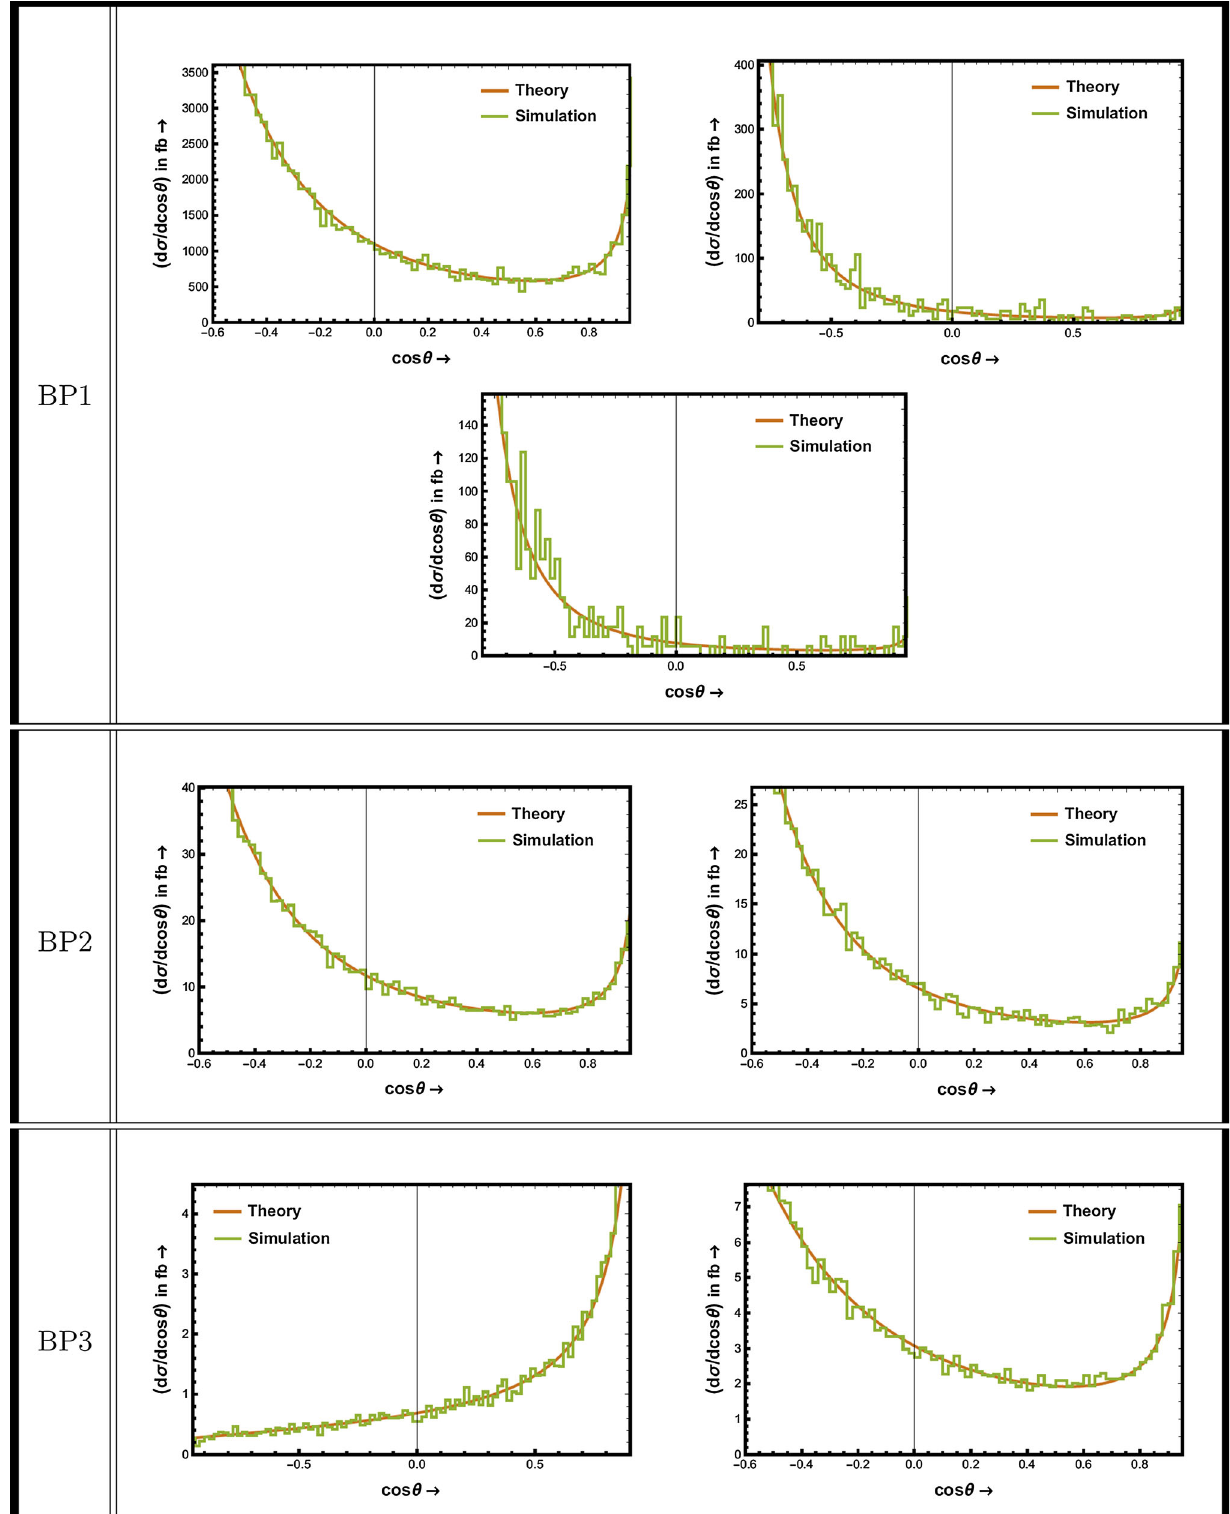
/ 3 ) c at various center of momentum energies for different benchmark points, arranged in the 3 μ